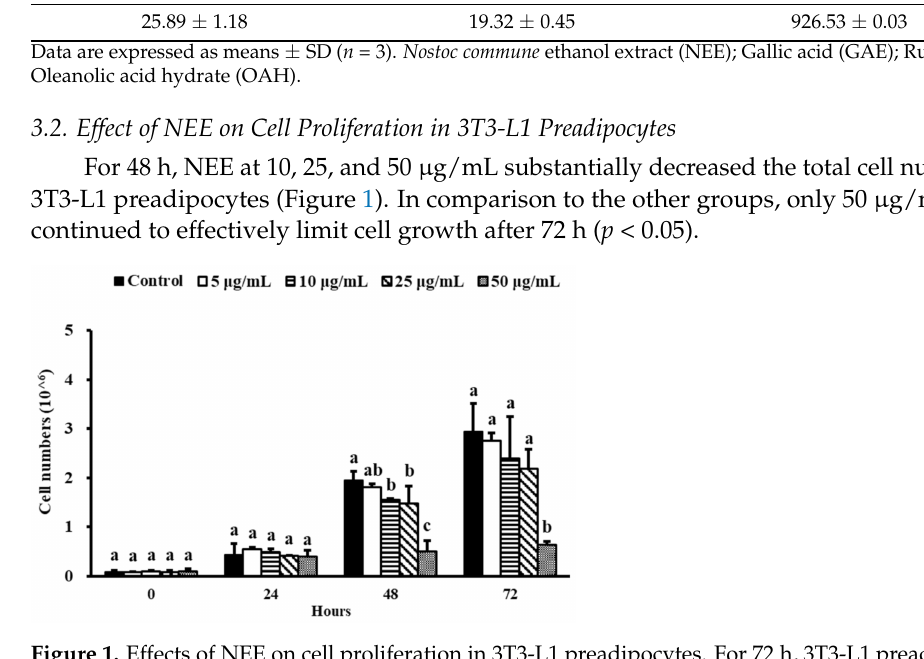
Figure 1. Effects of NEE on cell proliferation in 3T3-L1 preadipocytes. For 72 h, 3T3-L1 preadipocytes were treated or not treated with 5, 10, 25, 50 µ g/mL NEE. Duncan’s test was used to determine the significance of the variation in cell proliferation. The results shown are the means and standard deviations ( n = 3). Significant differences ( p < 0.05) between the different concentrations of the NEE group are indicated by different letters (a–c) .